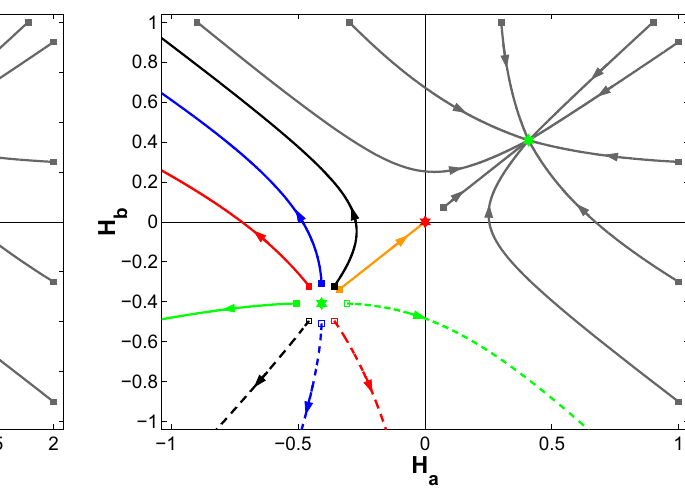
Fig. 1 Phase portraits for N = 2, f 0 = 1 f 0 = − 1 (right). Red and green stars denote the point ( 0 ; 0 ) and de 5 Sitter ones ( H dS ; H dS ) correspondingly. Initial points ( H a ( 0 ) ; H b ( 0 )) have the following coordinates: 1 for black, blue, red and green squares H a ( 0 ) equaling values from H dS − 0 . 1 to H dS + 0 . 1, where H dS < 0, with step 0.05 and corresponding values H b ( 0 ) =